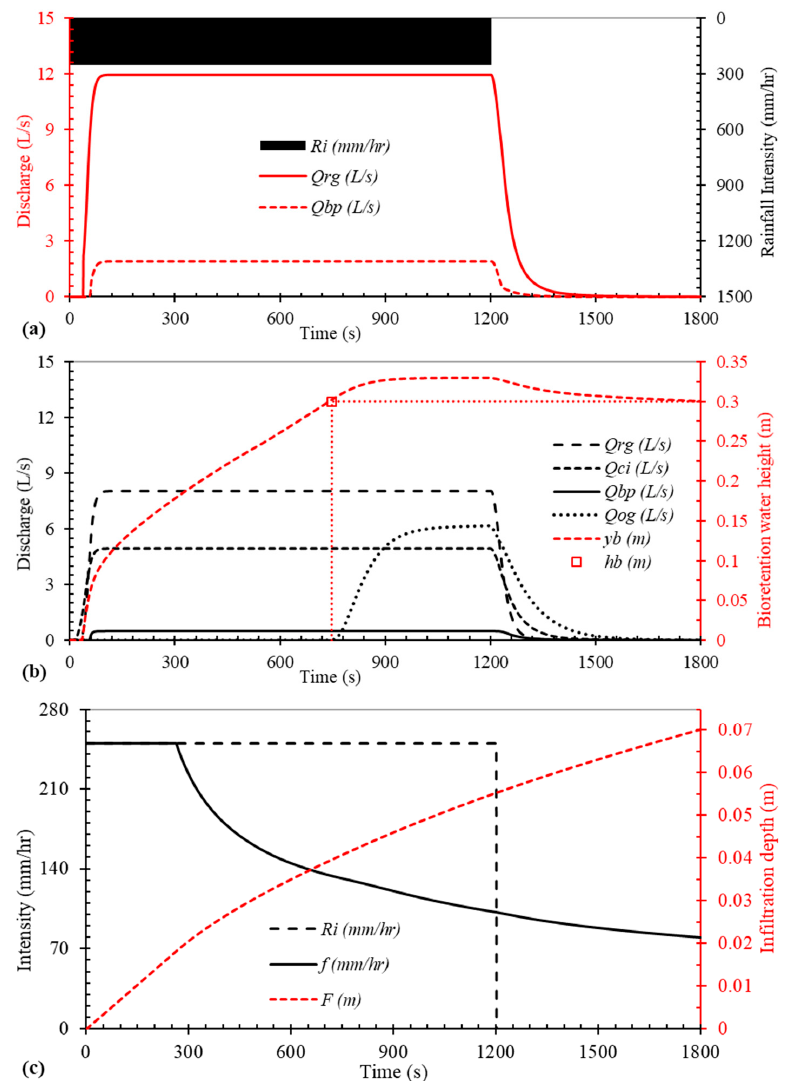
Figure 6. Simulation results of case Rd19 ( a ) and case RBS19 with an undepressed curb inlet ( b , c ). All symbols are defined in the text and summarized in Appendix A.